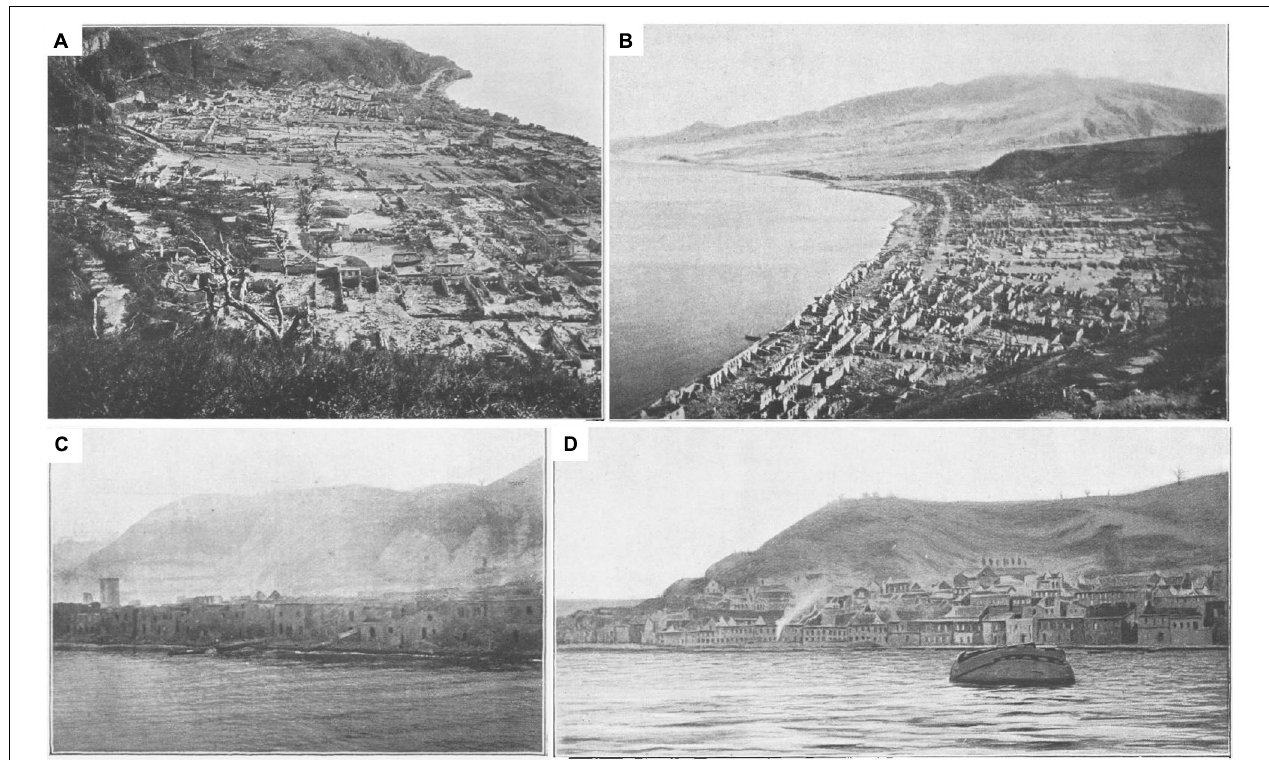
FIGURE 2 | Pictures of St Pierre after the eruption, from Lacroix (1904). (A,B) Were taken in August 1902 from Morne Abel looking south (A) and from Morne d’Orange looking north (B) . (C,B) Were taken in May 11th, 1902, 3 days after the passage of the pyroclastic current, from a boat a few hundred meters off the coast. It shows the Mouillage and Center districts only partially destroyed. See Figure 9 for a closer view of St Pierre city map.